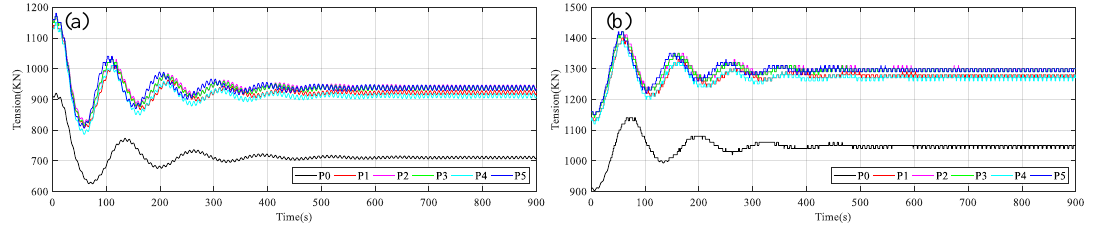
Figure 16. Fairlead tension in load case 3 for ( a ) fairlead 1, ( b ) fairlead 2.